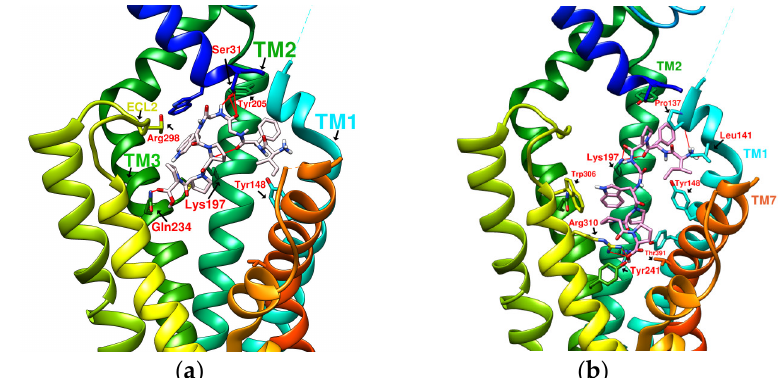
Figure 10. ( a ) IFGGWPPP N7 (−10.7 kcal/mol), ( b ) IFPGWPPP N11 (−11.0 kcal/mol).